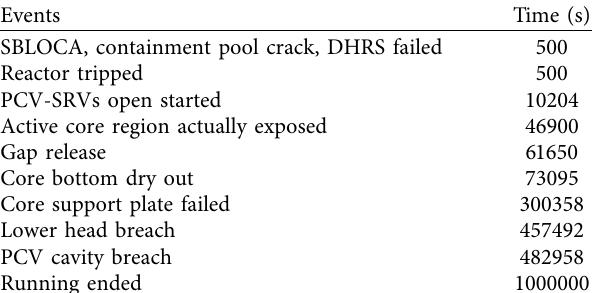
Table 2: Sequence of severe